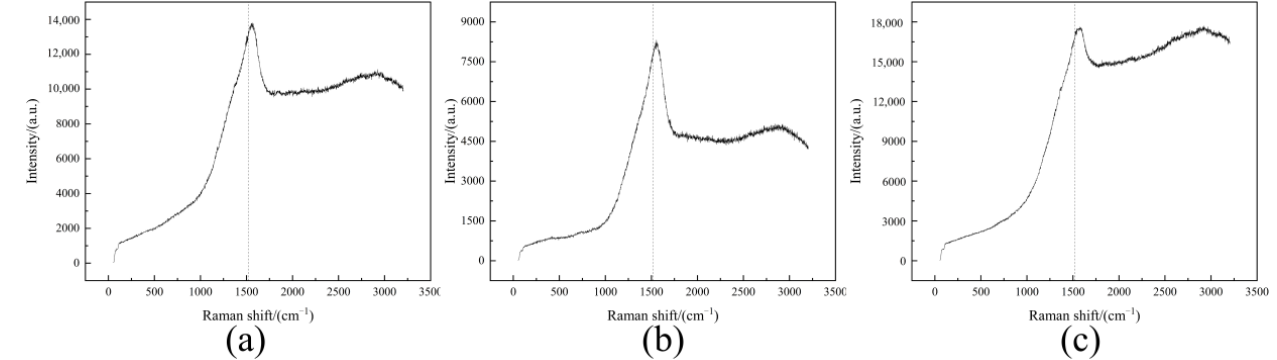
Figure 4. Raman spectra of Si-DLC with different transition layers: ( a ) AlTiSiN/Si-DLC; ( b ) AlCrN/Si-DLC; ( c ) AlTiCrN/Si-DLC.